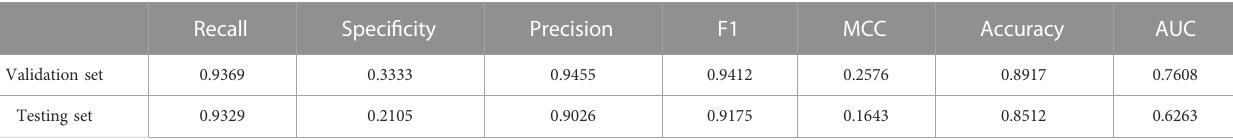
TABLE 2 Predictions of CNN Model on validation set and testing